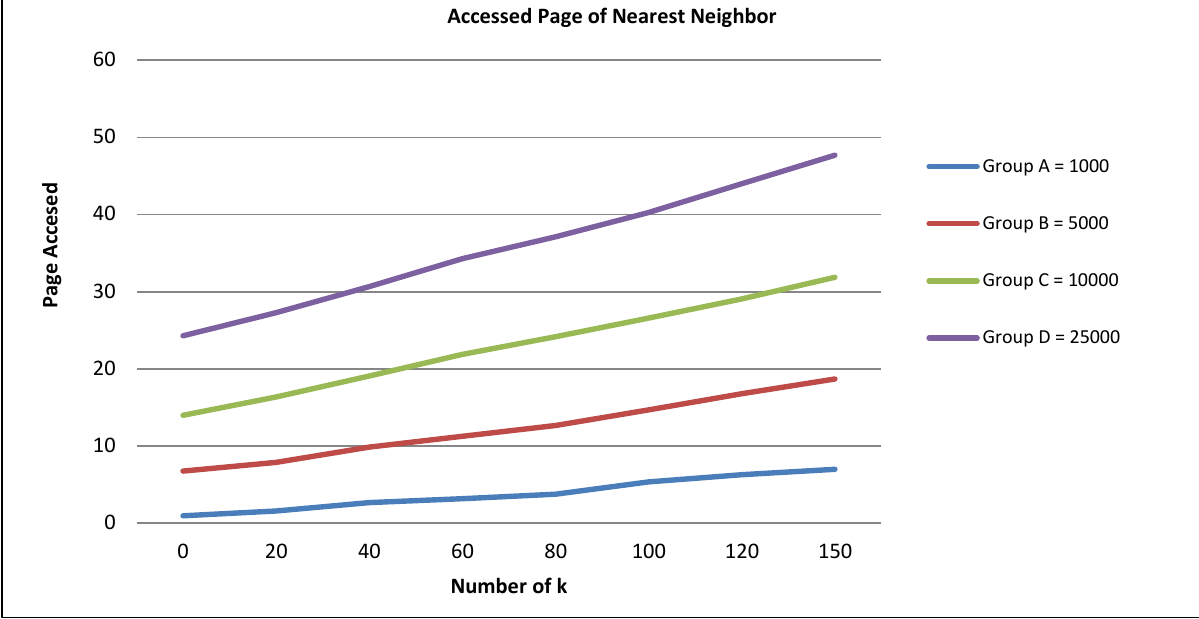
Figure 7. Effect of k number of nearest neighbour to access page.